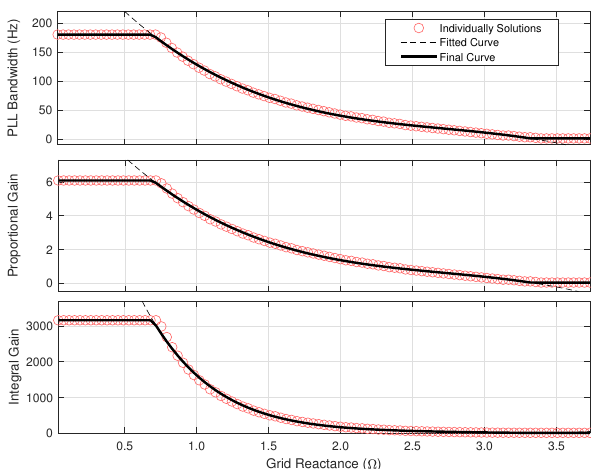
Figure 7. Fitted functions from grid reactance to PLL bandwidth and control parameters.